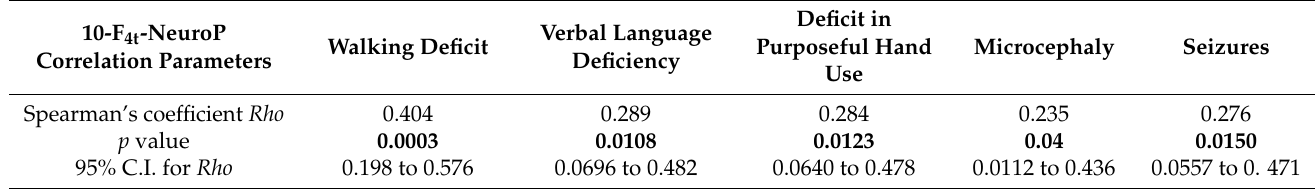
Table 6. Correlation matrix for 10-F 4t -NeuroP as a function of RCSS